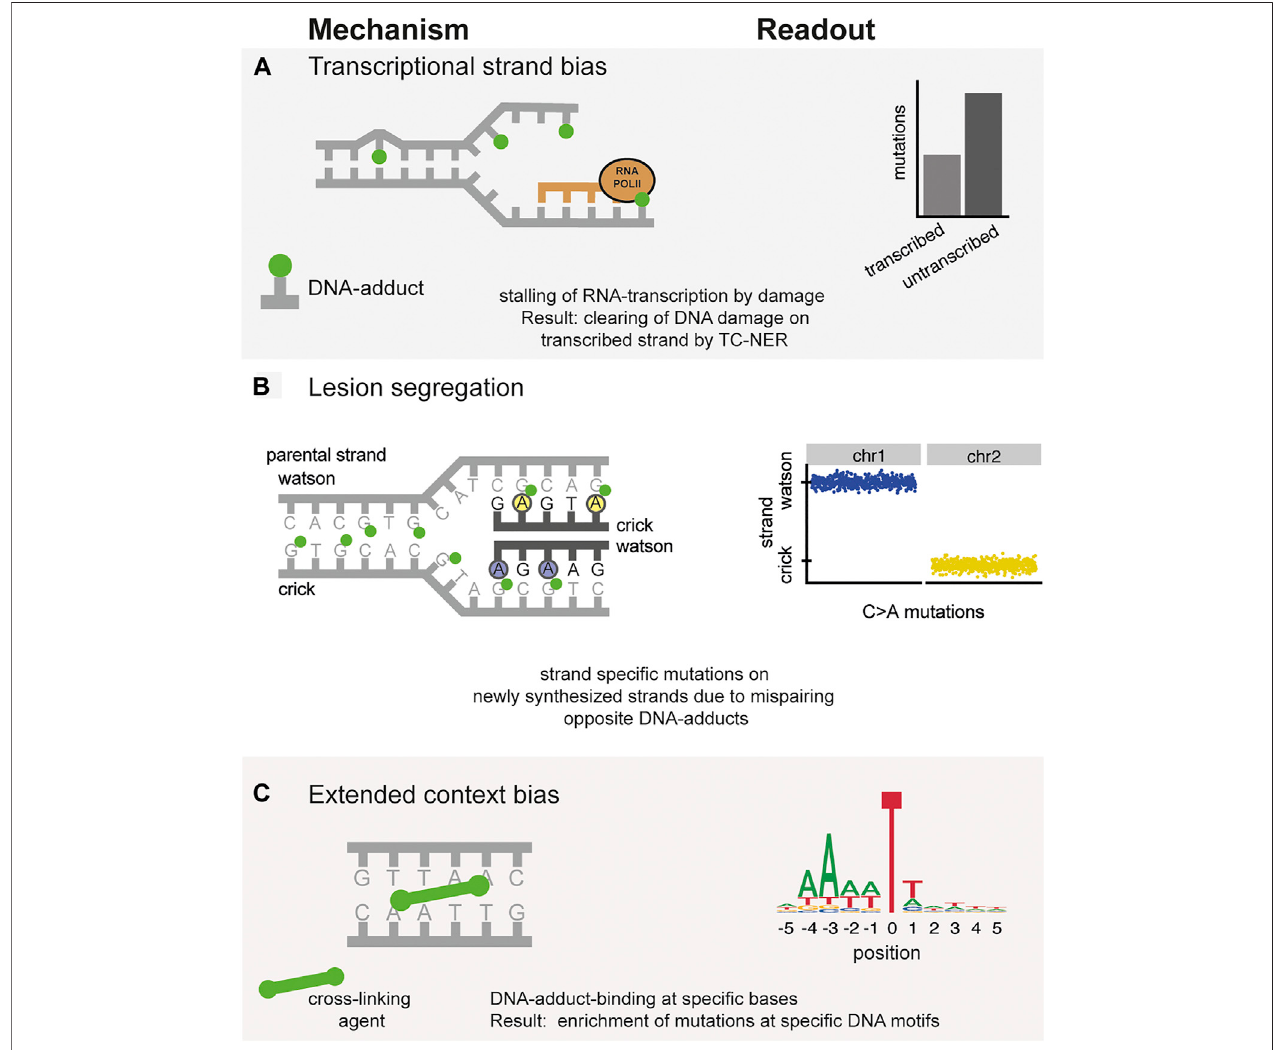
FIGURE 2 | Mechanisms underlying topographical differences in mutation accumulation. Left column: Molecular mechanism of mutation induction. Right column: Typicalreadoutoftheseprocessesinmutationdatacatalogues. (A) Transcriptionalstrandbias.MutationsindicatedingreenarepreferentiallyrepairedbyTC-NERonthe transcribed strand. (B) Incorporation of mutations opposite of DNA-adducts during replication results in the asymmetric division of mutations on either the Watson or Crick strand. (C) Preferential binding of DNA-damaging agents to speci fi c contexts, resulting in the extended-context biases of